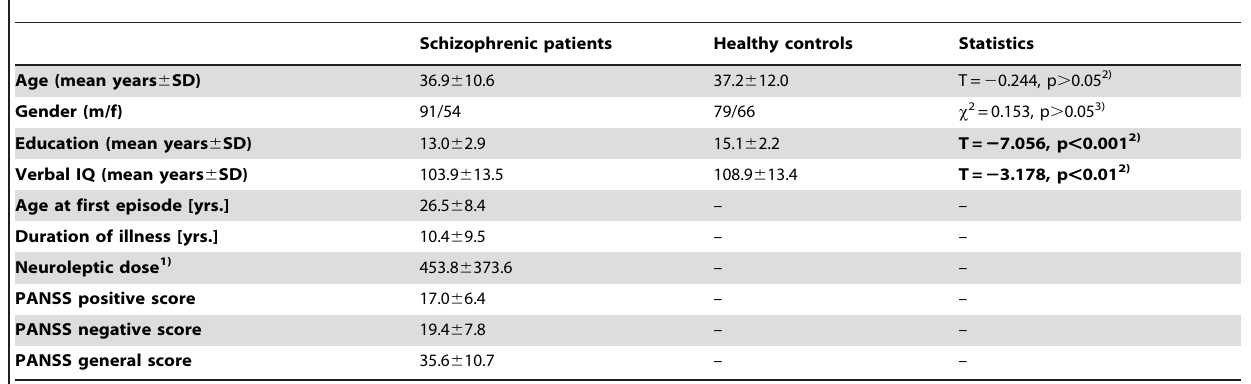
Table 1. Demographic data and disease characteristics in schizophrenic patients (n =145) and controls (n= 145); between-group